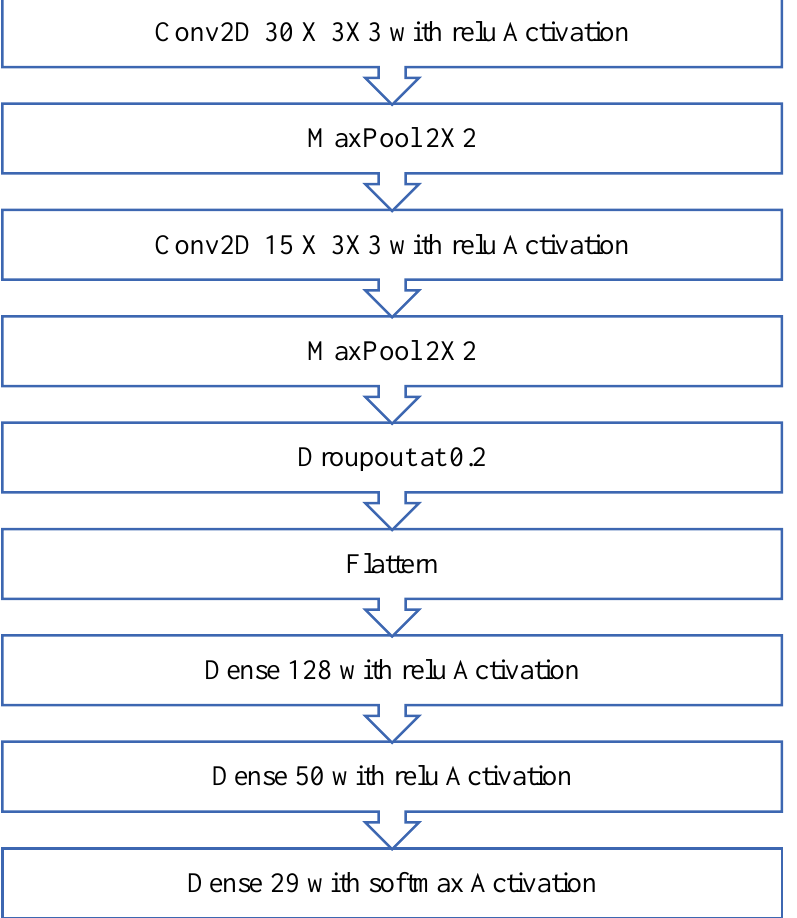
Figure 2. The model description is as follow The model promises an acceptable accuracy when it is trained with 100 epochs on a CPU or GPU